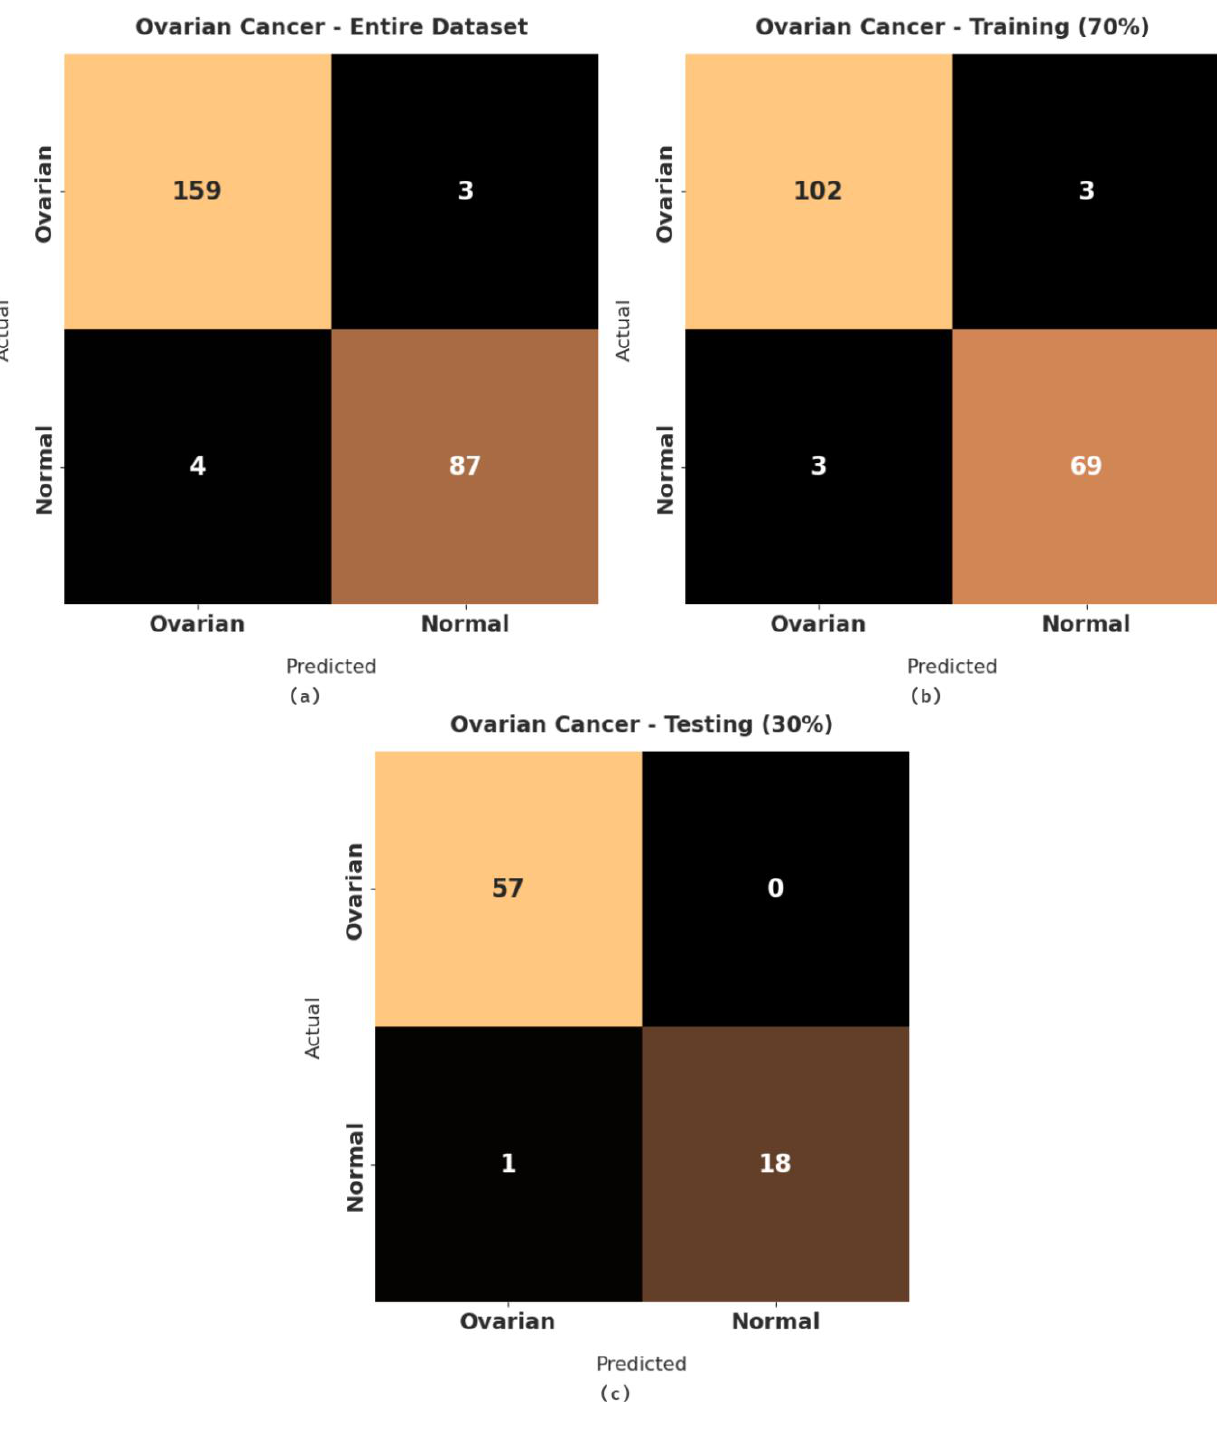
Figure 9. Confusion matrices of RFODL-MGEC technique on ovarian cancer dataset. (a) Entire dataset, (b) 70% of training dataset, and (c) 30% of testing dataset